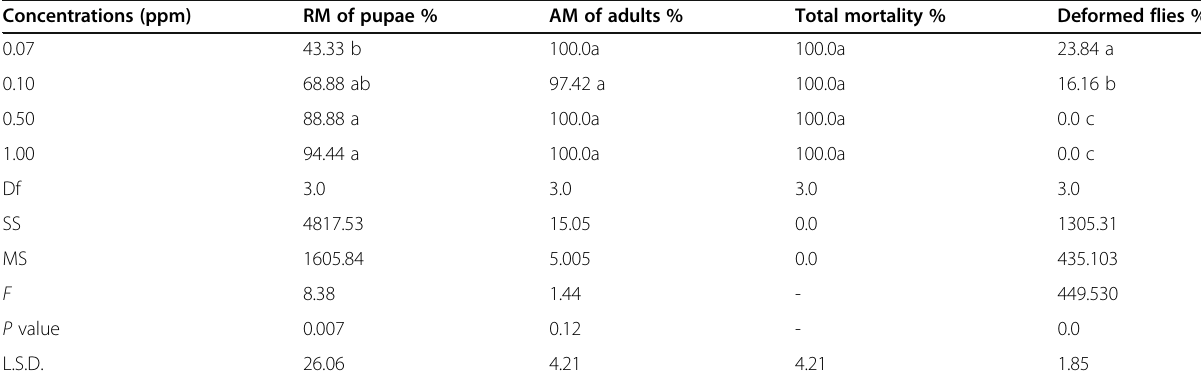
Table 1 The real and apparent mortalities, and deformed flies percentages of the peach fruit fly, Bactrocera zonata , treated with diazinon pesticide at pupal stage Concentrations